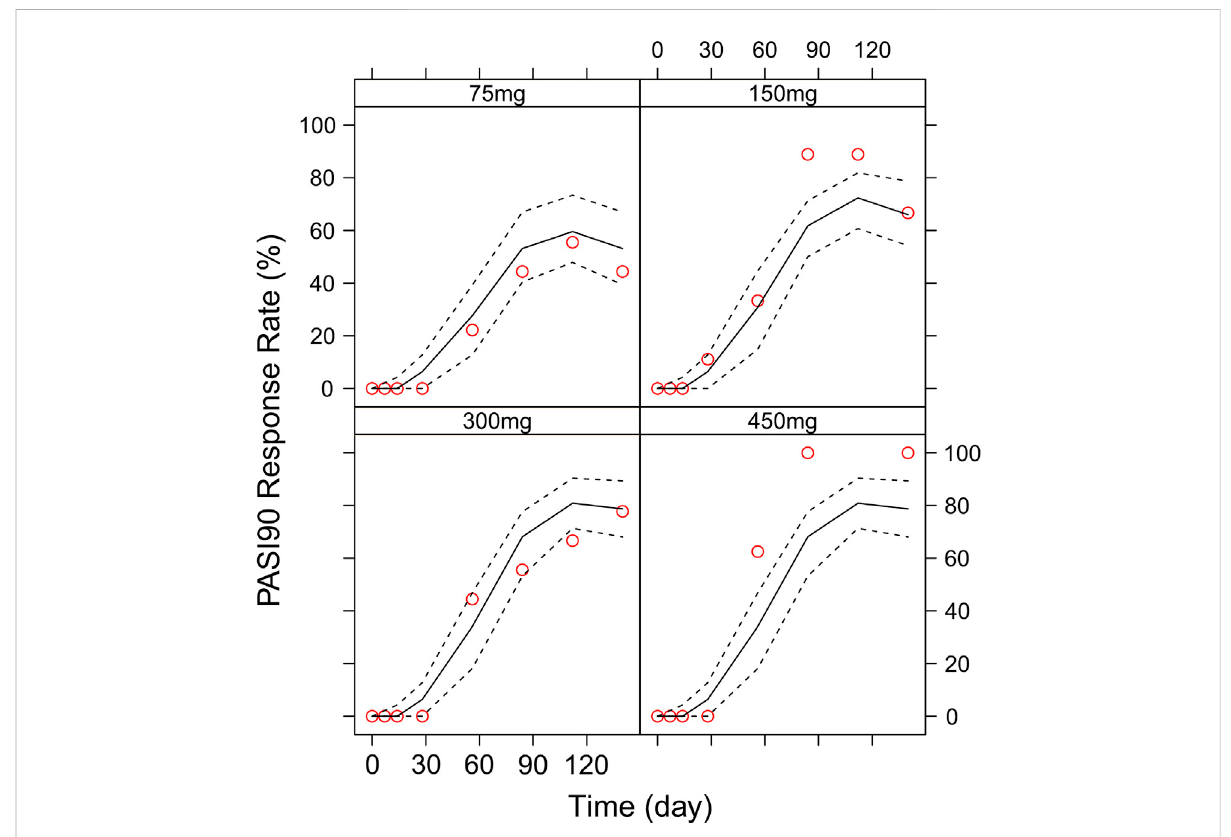
FIGURE 9 Comparison of the observed time pro fi les of the PASI75 and PASI90 response rates versus model-predicted time pro fi les strati fi ed by dose. Observed and predicted PASI90 response rates strati fi ed by dose. Red circles represent observed response rates; black lines represent the 50th percentile of the predicted response rate; the two black-dotted lines represent a 95 % con fi dence interval for the predicted response